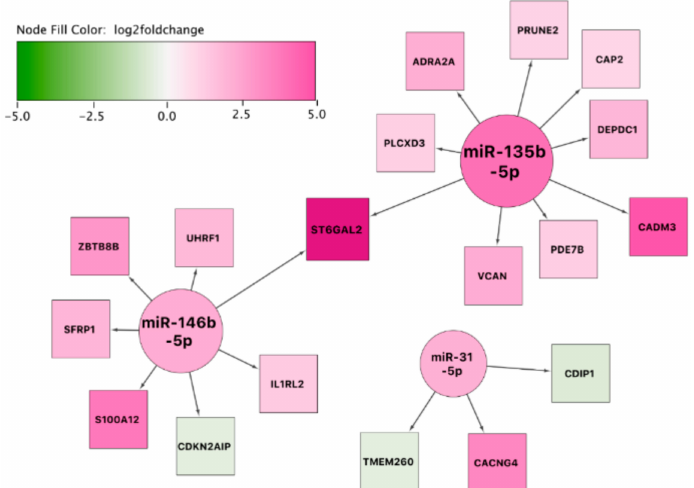
Figure 7. miRNA-gene interaction network using the set of di ff erentially expressed miRNAs and mRNAs between a ff ected horses in exacerbation and remission. The color of the interior of the nodes represents the reported log2 fold change of the miRNA or gene, the node shape represents the feature type (miRNA: circle, target gene: square), and the node size represents the degree (number of in- and outgoing